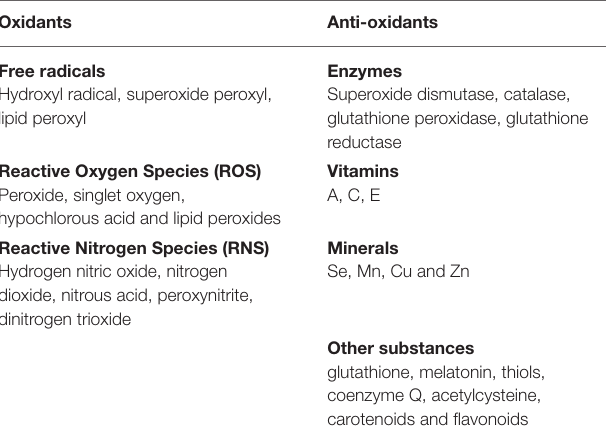
TABLE 1 | Main oxidants and anti-oxidants. Oxidants